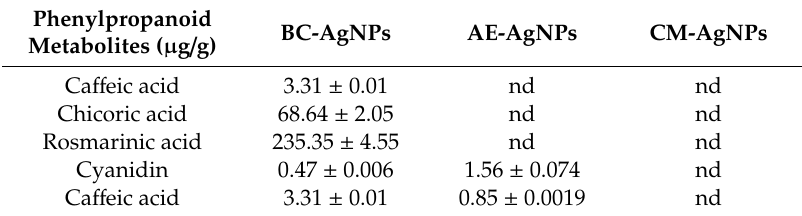
Table 1. Detection of phenylpropanoids metabolites by HPLC from BC-AgNPs, AE- AgNPs and CM-AgNPs. nd: Not